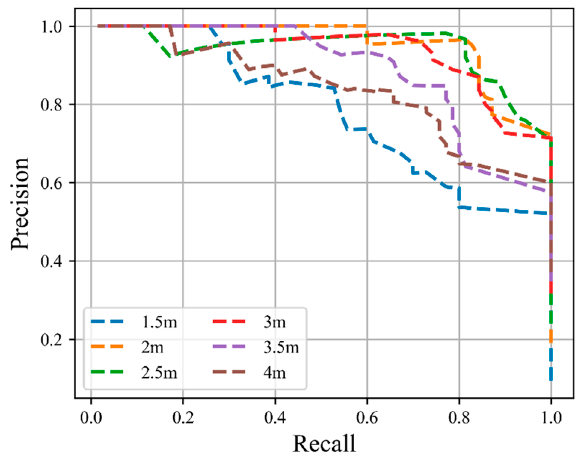
Figure 15. Precision–recall curves for images with different resolutions.